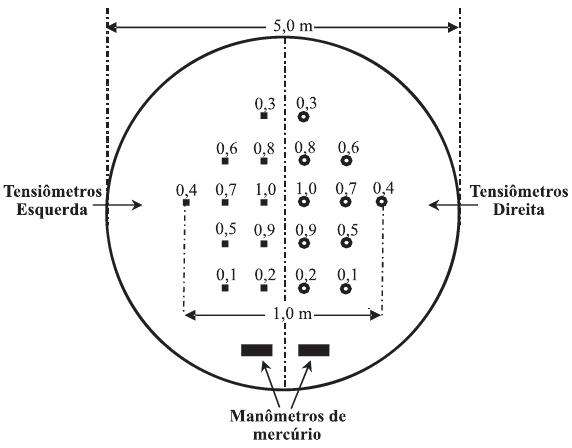
Figura 1. Disposição dos tensiômetros e manômetros de mercúrio na área confinada (quadrados simbolizam a bateria de tensiômetros da esquerda e circunferências da direita). Os números acima dos símbolos representam a profundidade (m) na qual foram instalados. Notar que os mais profundos ficaram no centro da área e os mais rasos na